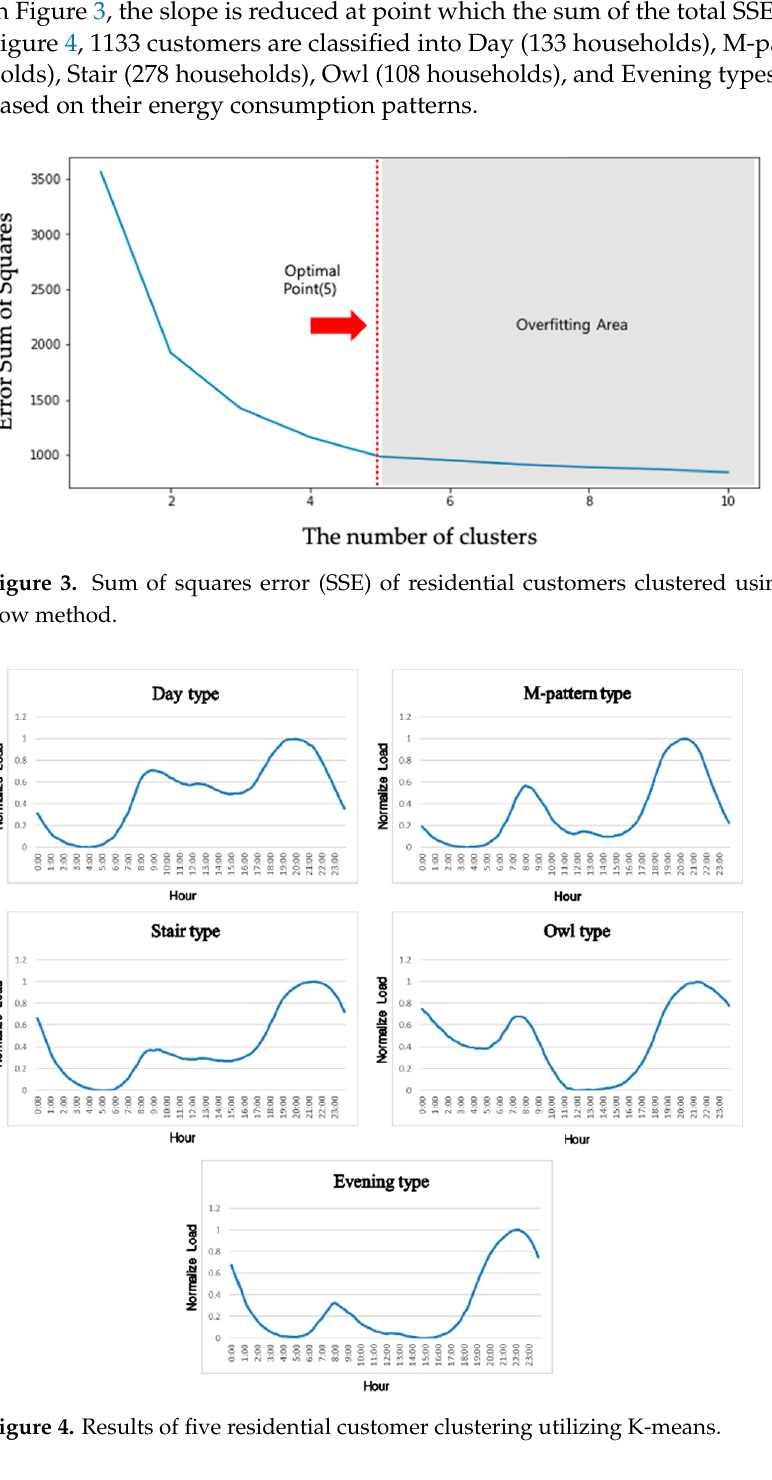
Figure 2. Difference of RMSE between statistical and linear imputation as the number of missing values increases.